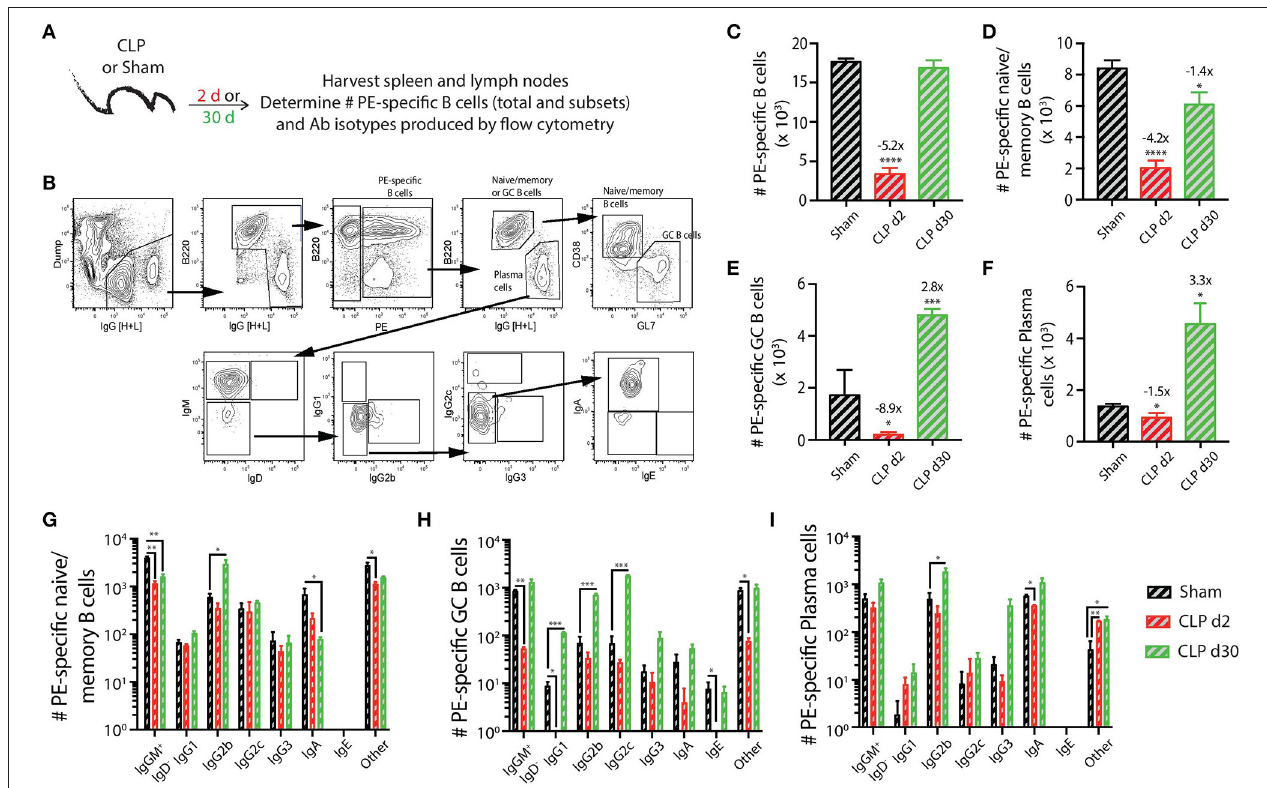
FIGURE 2 | Numerical changes in PE-specific B cells after sepsis. (A) Experimental design—Spleens and peripheral lymph nodes (axillary, brachial, cervical, inguinal, and mesenteric) were harvested from mice on day 2 and 30 post-sham or CLP surgery and combined. (B) Gating scheme used to identify PE-specific B cells, as well as the B220 hi IgG [H + L] lo CD38 + GL7 − naïve/memory B cells, B220 hi IgG [H + L] lo CD38 − GL7 + germinal center (GC) B cells, and B220 lo IgG [H + L] hi CD38 − GL7 − plasma cells. This representative scheme also shows the gating used to determine the extent of class switching within the plasma cell population, but similar gating was used on the naïve/memory and GC B cell populations. Representative flow plots are from a mouse that underwent sham surgery. The number of (C) total PE-specific B cells and PE-specific (D) naïve/memory B cells, defined as B220 hi IgG [H + L] lo CD38 + GL7 − , (E) germinal center (GC) B cells, defined as B220 hi IgG [H + L] lo CD38 − GL7 + , and (F) plasma cells, defined as B220 lo IgG [H + L] hi CD38 − GL7 − , were determined. Numbers above bars indicate the average fold change in number compared to sham mice. (G–I) The naïve/memory B cell, GC B cell, and plasma cell subsets from the unimmunized mice were additionally subdivided based on the Ab isotype being produced. n = 5–7 mice/group. Statistical comparisons were made between sham mice and either CLP d2 or d30 mice, where * p < 0.05, ** p < 0.01, **** p < 0.001. Data are representative of at least 3 independent